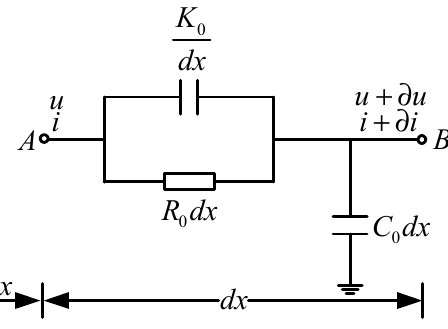
Figure 4. IOCT single-layer insulation equivalent circuit diagram. In Figure 4, u and i represent the voltage and current at the insulating layer x , and u + ∂ u and i + ∂ i represent the voltage, and current at x + dx . K 0 , R 0 , and C 0 are the distributed capacitance per unit thickness of the single-layer insulation, the resistance, and the capacitance to ground, respectively. K , R , and C are the total distributed capacitance, resistance, and ground capacitance of single-layer insulation, respectively. In fact, the conductance G of the insulating layer to the ground is very small, the conductance has little effect on the result, and in order to simplify the calculation, the conductance of the main insulating layer to the ground is ignored. Assuming that d is the thickness of the insulating layer, the relationship between them is shown in the following Equation (6):